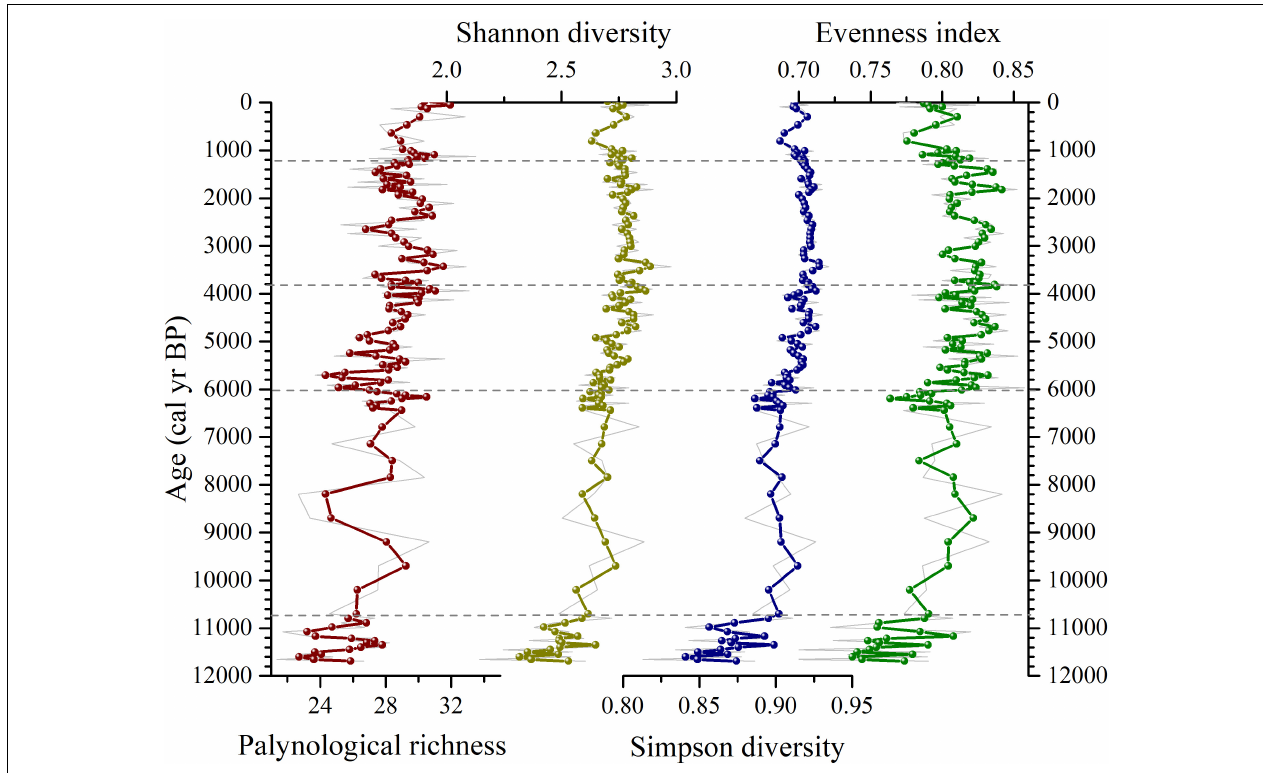
FIGURE 5 | Changes in palynological richness, Shannon and Simpson diversity, and evenness index at Daye Lake during the Holocene. The gray curves are the original data and the colored lines are a 5-point smoothing data. The red line indicates palynological richness based on the total number of taxa, the yellowish-green line is Shannon’s diversity based on the number of common taxa, and the blue and green lines are Simpson’s diversity based on the number of dominated taxa and evenness,